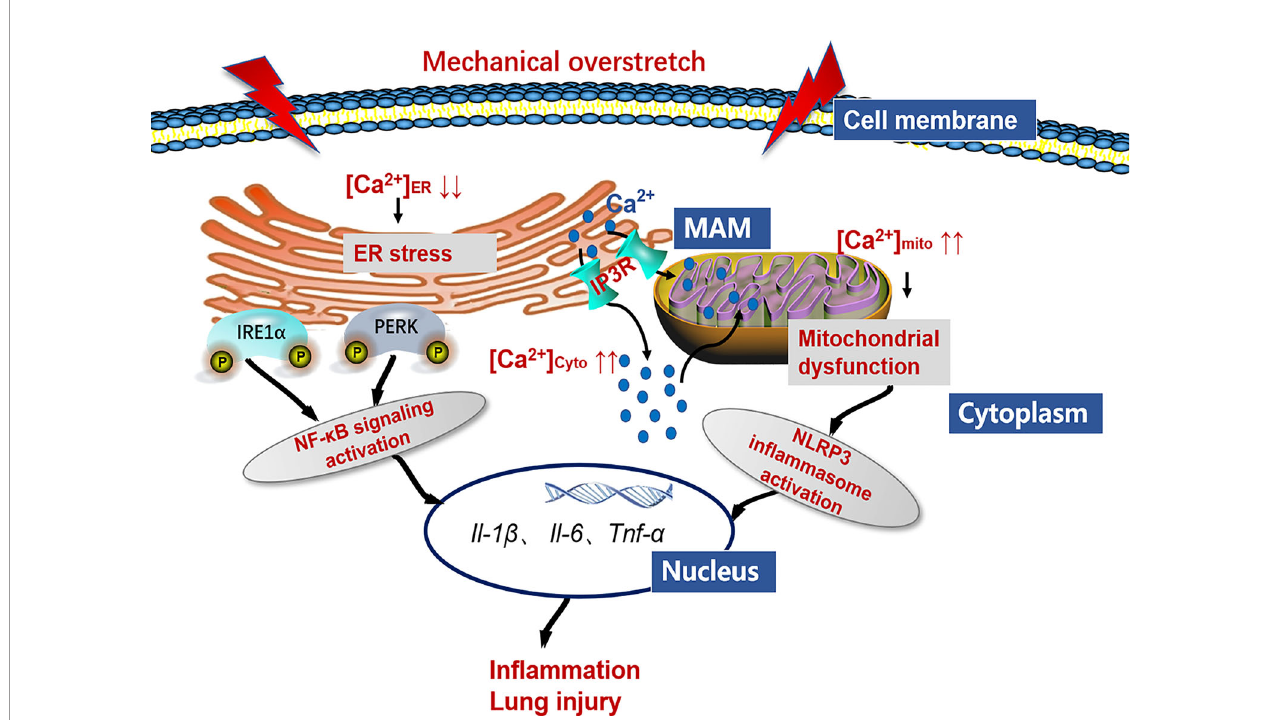
FIGURE 12 | Working model detailing the role of IP3R/Ca2+ in VILI. Mechanical overstretch induces cell in fl ammation through an accelerated ER-to-cytosolic and ER-to-mitochondria ef fl ux of Ca2+ through IP3R, followed by ER stress and mitochondrial